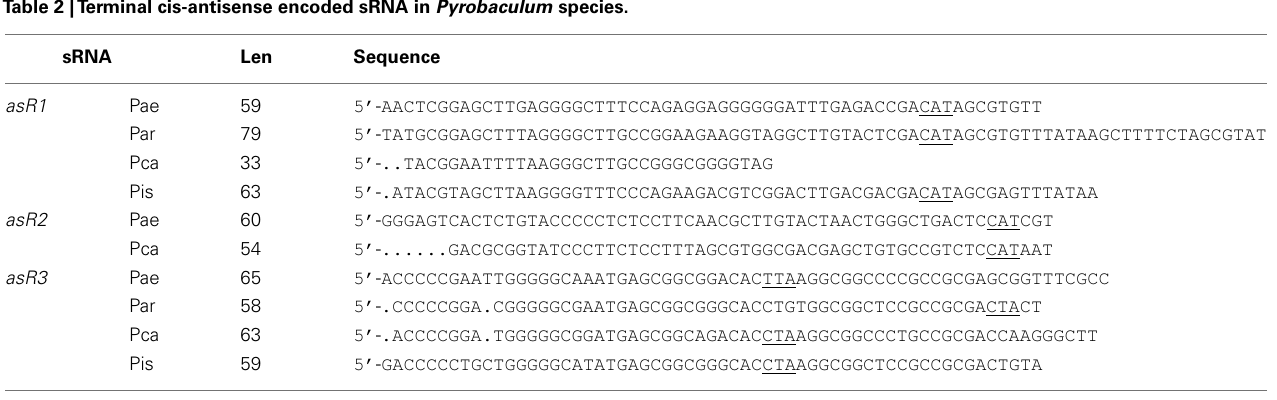
FIGURE 4 | Cis -antisense transcription occurring at three conserved loci in Pyrobaculum spp. The antisense sRNA genes (indicated as asR1 , asR2 , and asR3 ) are defined over the region of antisense-oriented sequencing reads (shown in red) with the associated gene (sense orientation) shown in blue. (A) Sequencing reads map to the 5 (cid:48) terminus of transcription initiation factor B in both sense and antisense orientations (Pars_1976 is shown from Pyrobaculum arsenaticum ). Sense oriented transcripts (blue) are present in two populations, consistent with the two